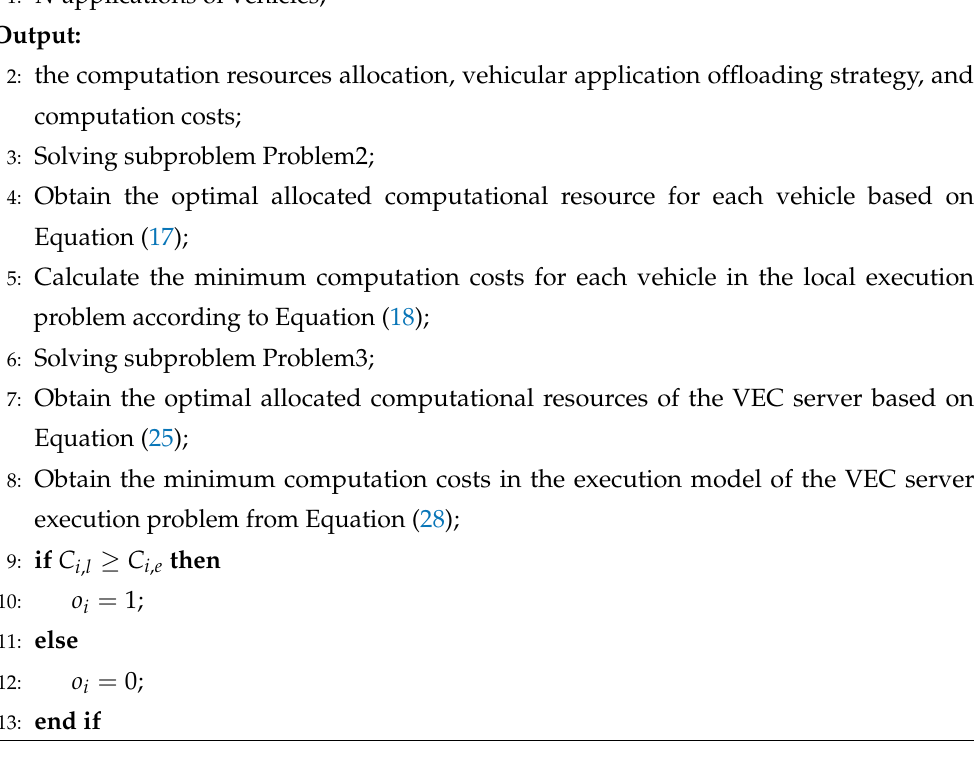
Algorithm 1 The Proposed Vehicular Application Offloading